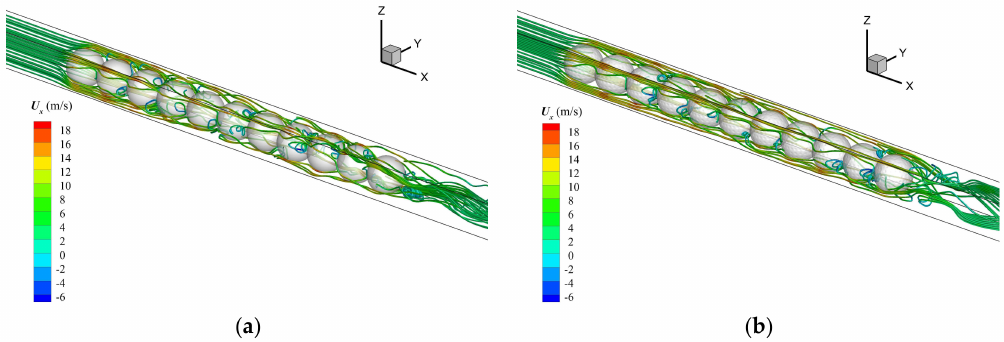
Figure 8. The streamlines of ( a ) SPBS; and ( b ) SPBD at N = 1.00 ( Re H = 5013).